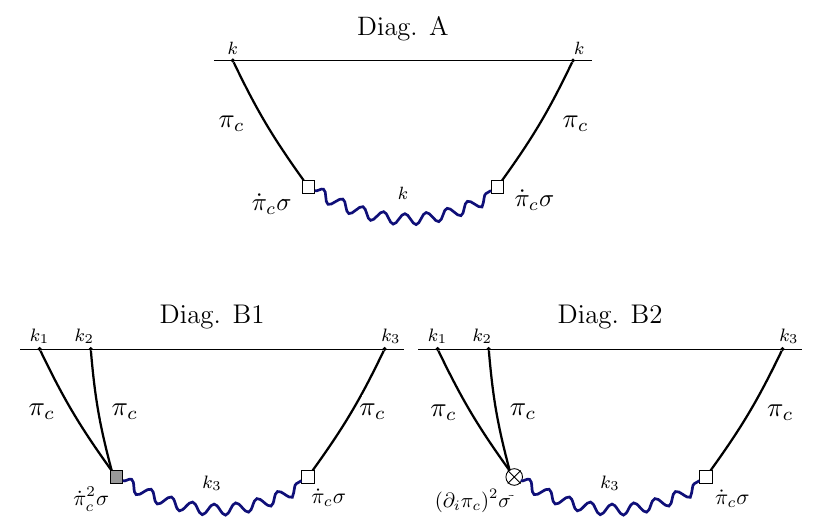
Figure 4 . In this work we study in detail the three depicted single-exchange diagrams for the two- and three-point correlation functions of π . The white rectangle represents the linear mixing operator c ˙ π , whereas the gray rectangle and the crossed circle stand for the ˙ π 2 σ and ( ∂ i π c ) 2 σ vertices, c σ c respectively. We also obtain the results for the three corresponding single-exchange four-point functions, with interactions either ˙ π 2 σ or ( ∂ i π c ) 2 σ at each c